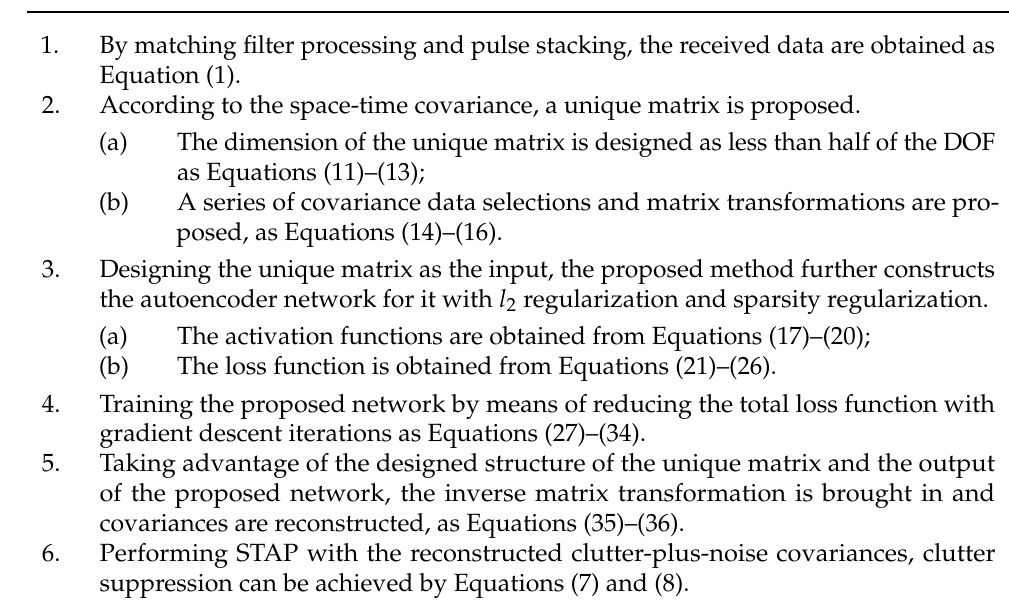
Table 1. Summary of the proposed